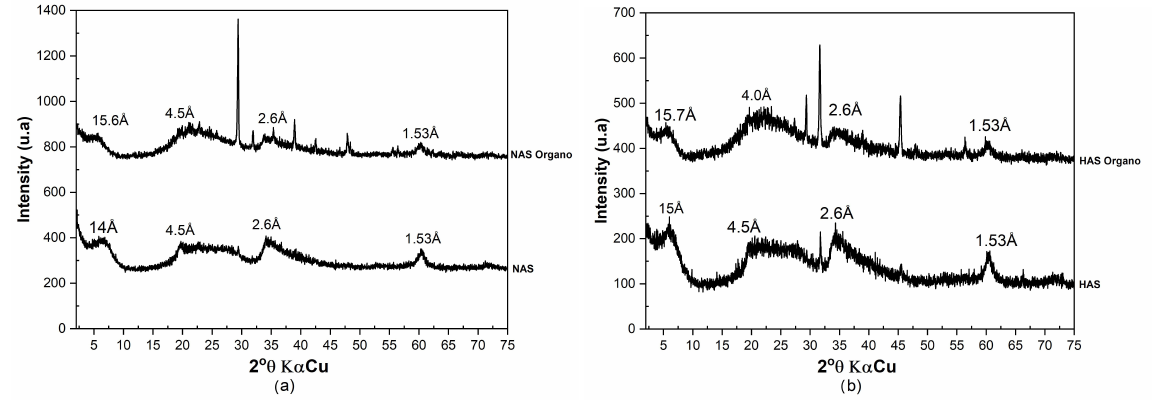
Figure 7. XRD curves of organophilized clays ( a ) NAS and ( b ) HAS produced by the semi-dry process.